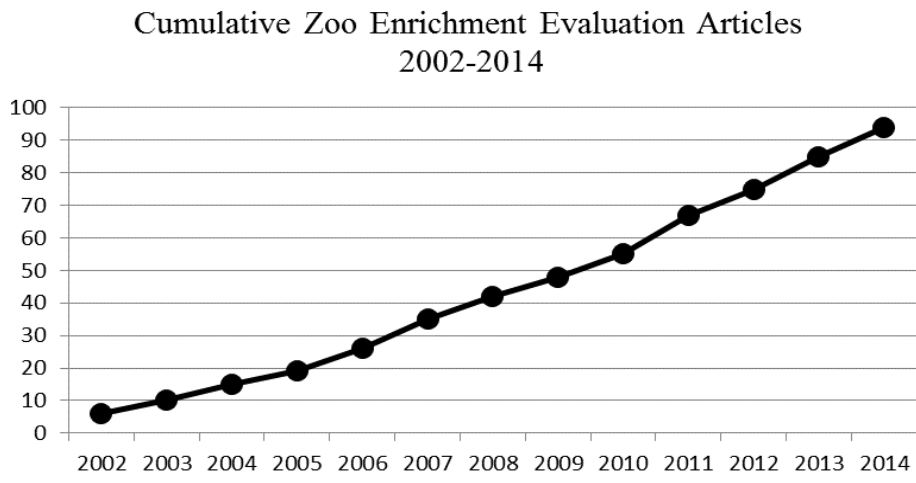
Figure 1. Cumulative number of selected peer-reviewed zoo enrichment evaluation articles, 2002 –